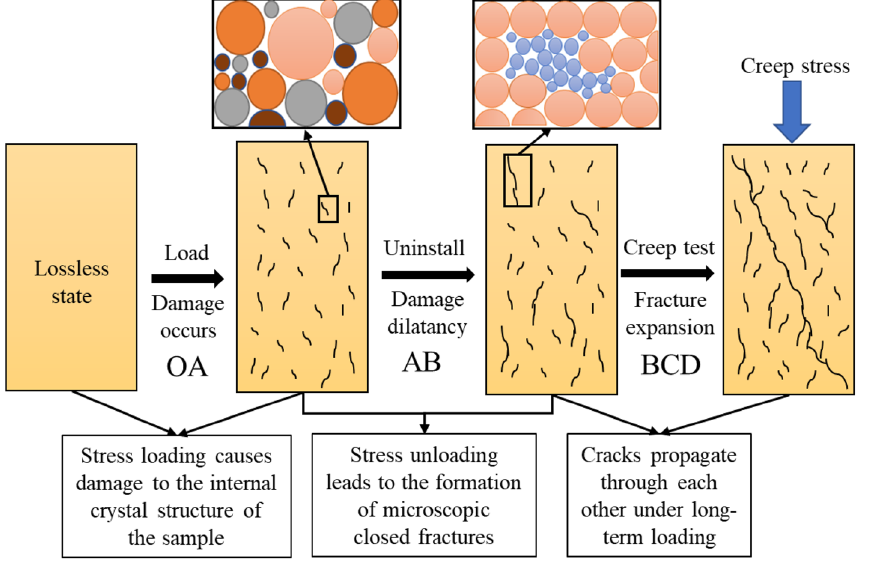
Figure 16. Damage and fracture evolution